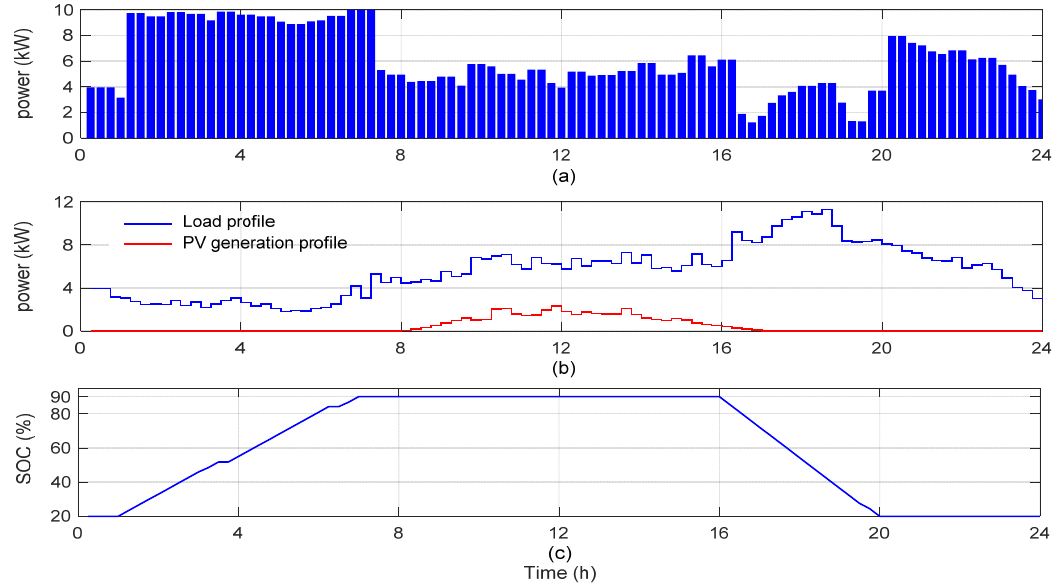
Figure 10. ( a ) Reference values for the power drawn by the MG from the main grid for winter; ( b ) MG’s forecasted load and PV generation profiles; ( c ) Resultant state of charge curve of the BESS.